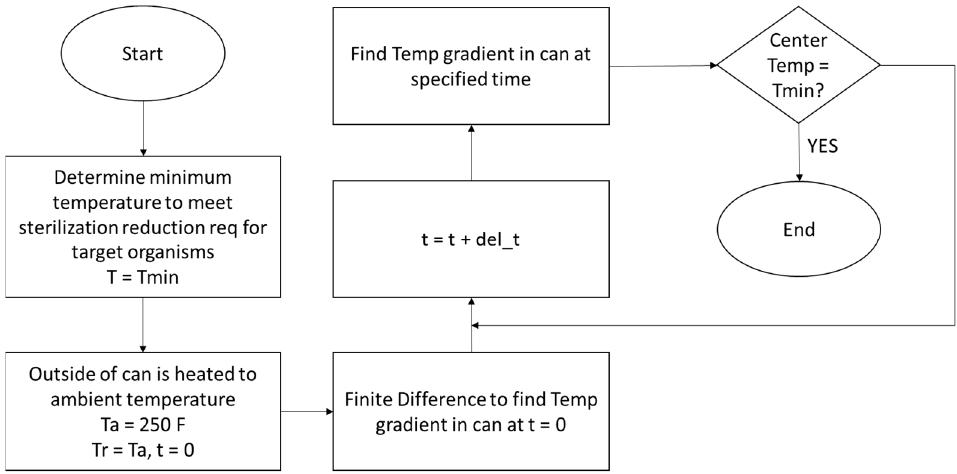
Figure 1. Diagram coded as stepwise approach as a type of algorithmic thinking .